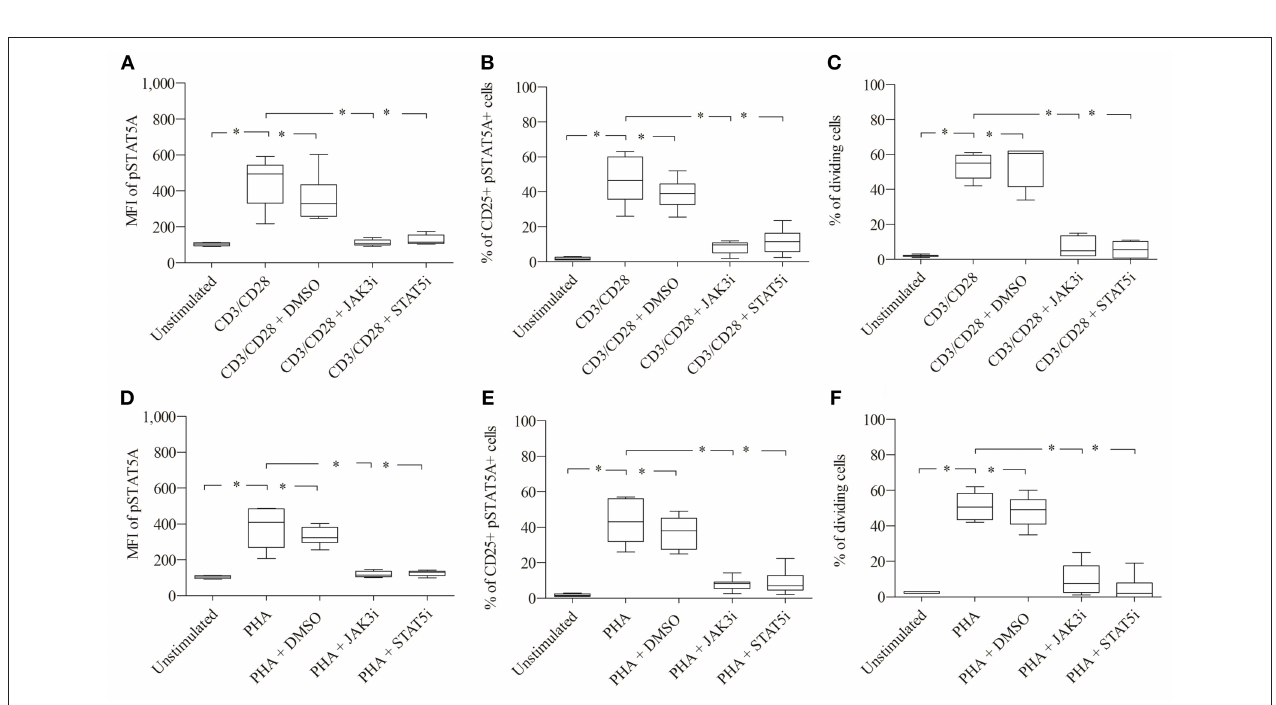
FIGURE 4 | Role of pSTAT5A in T cell proliferation. CD3/CD28 or PHA stimulated T cells were treated either with DMSO (solvent control, 0.07 %), JAK3i (12 µ M) or STAT5i (35 µ M). After 24h the MFI of pSTAT5 (A,D) the percentage of CD25 + pSTAT5A + cells (B,E) and after 72h proliferation (C,F) were determined, The bold line inside each box plot shows the median, upper and lower lines indicate the maximum and minimum values, respectively (Curves were evaluated by the non-parametric Friedman test). * p < 0.05 (Wilcoxon’s test); n = 6 independent experiments; MFI, median fluorescence intensity; Jak3i, Janus kinase 3 inhibitor; STAT5i, signal transducer and activator of transcription 5